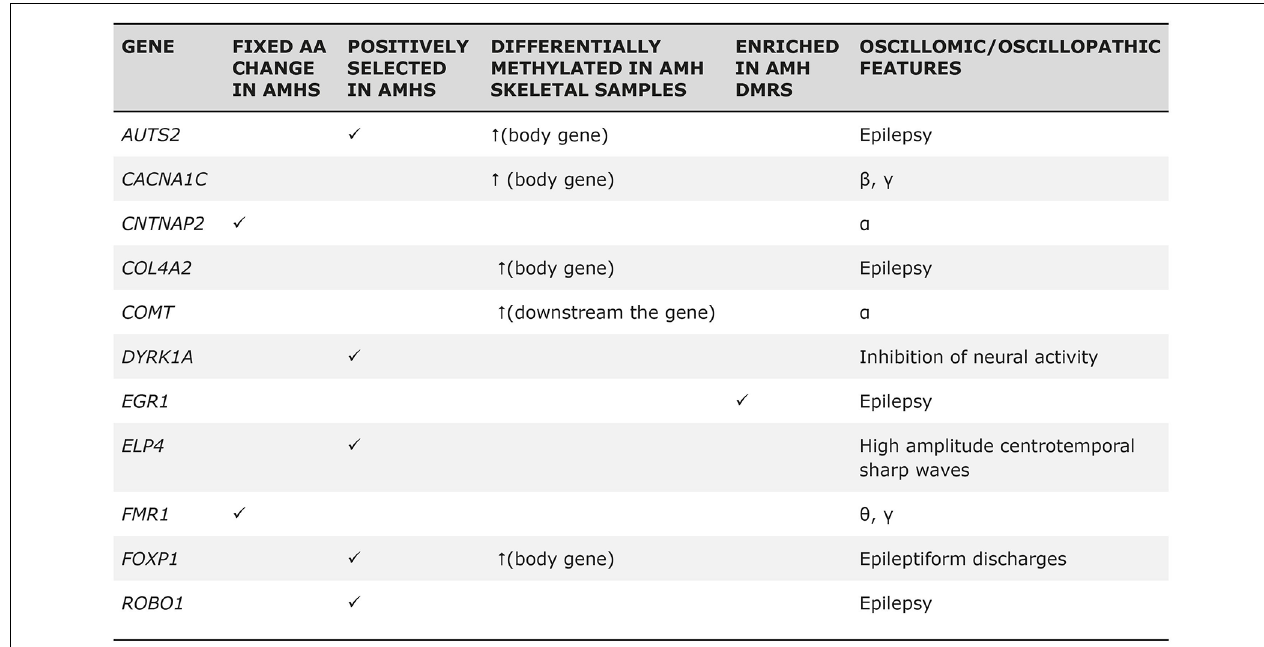
FIGURE 5 | The “Why” Question. Selected genes encompassing the language oscillogenome exhibit fixed derived changes in modern humans compared to extinct Neanderthals, either in their regulatory or coding regions, or in their methylation patterns (suggestive of differences in their expression levels; reproduced from Murphy and Benítez-Burraco, 2018b; Table